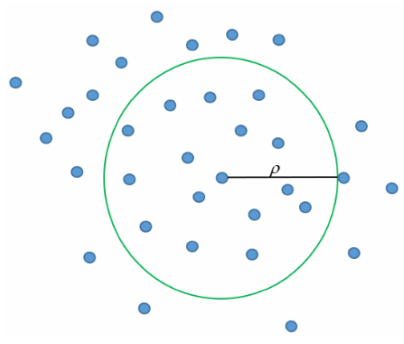
Figure 3. Diagram of Niche